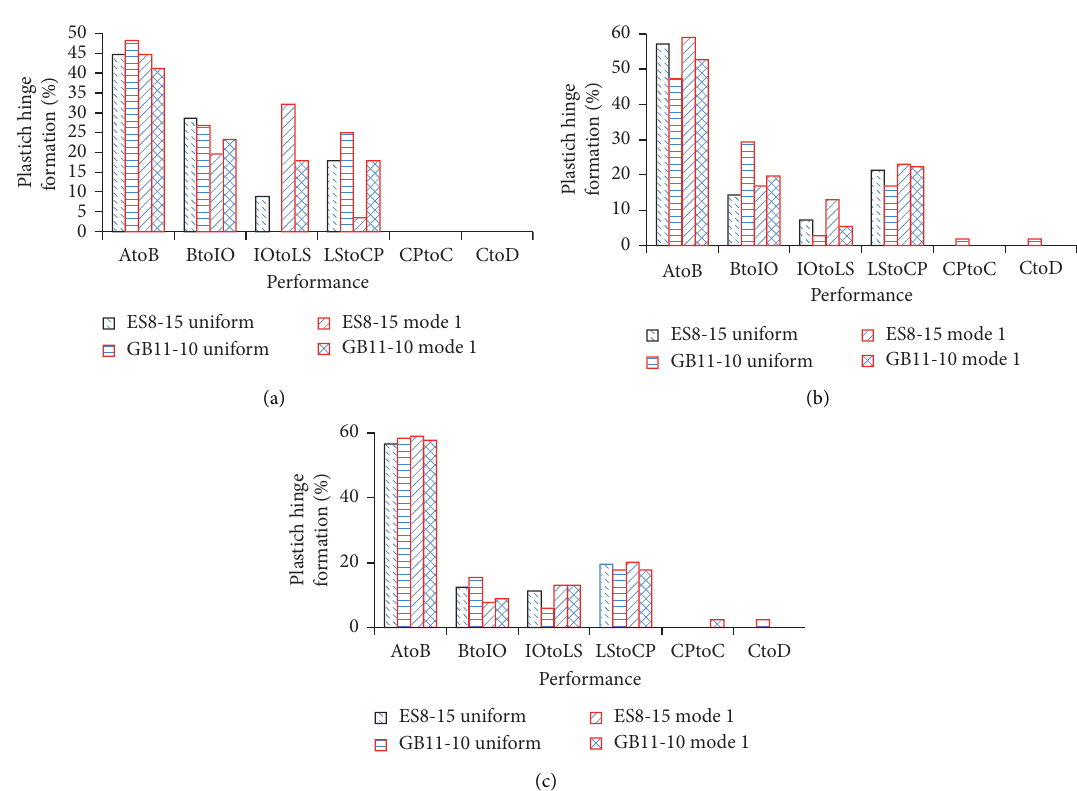
Figure 13: Total number of plastic hinges (%) formed: (a) 4-story, (b) 8-story, and (c)